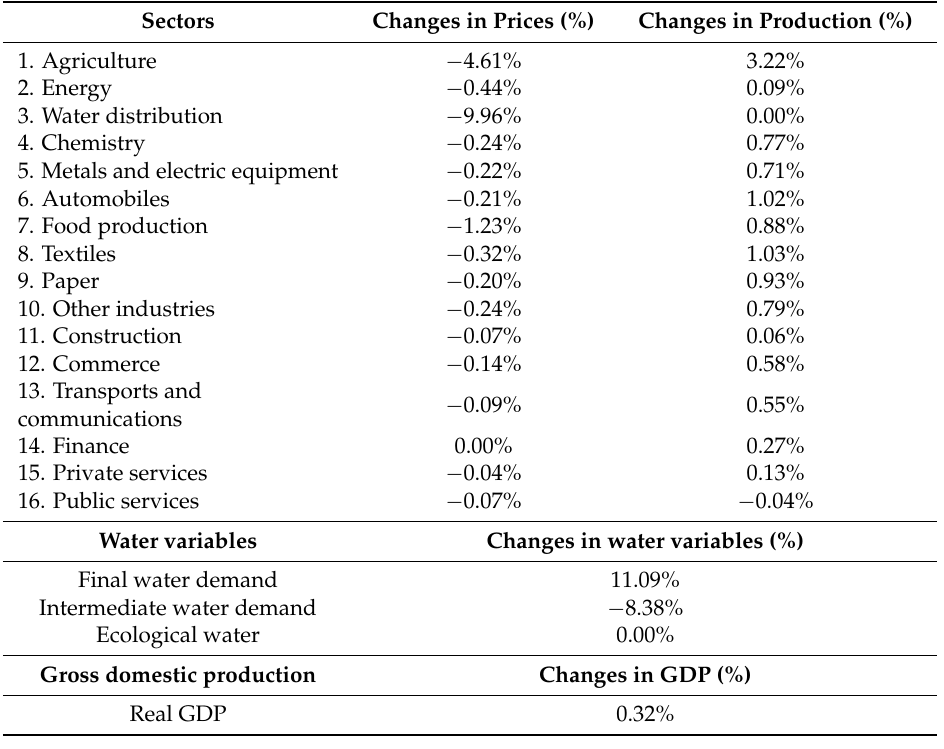
Table 2. Simulation 2: 25% increase in TPF of agriculture and 25% tax on water price (without water